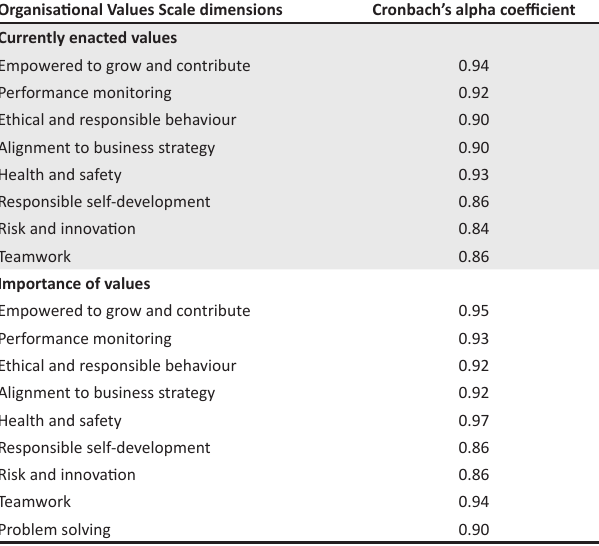
TABLE 2: Organisational Values Scale (OVS) - internal consistency reliability of sub-scales ( n =